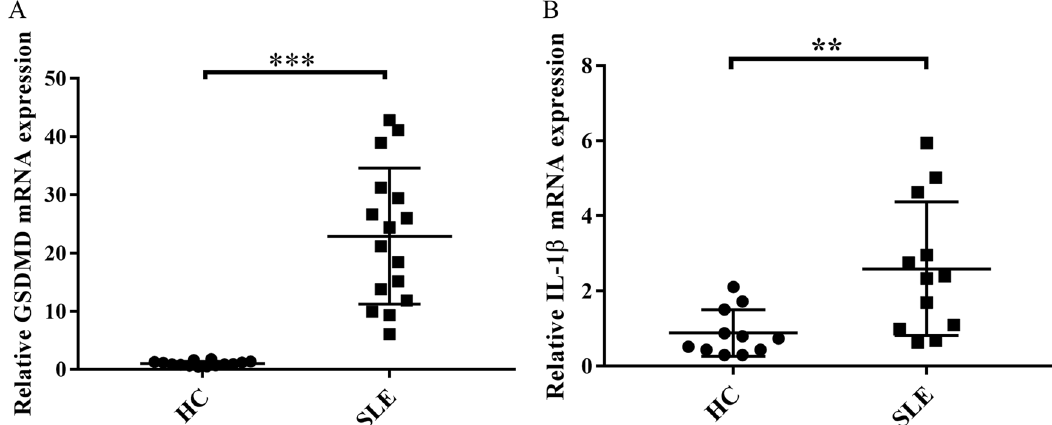
Fig. 1 mRNA expression of GSDMD and IL-1 β was increased in PBMCs from SLE patients. A GSDMD mRNA expression in PBMCs from SLE patients ( n = 16) and healthy controls (HC, n = 14). B mRNA expression of IL-1 β in PBMCs from SLE patients ( n = 12) and HC ( n = 11). mRNA determination was performed by real-time PCR. Values were shown as mean ± SD of three independent experiments. ** p < 0.01, *** p < 0.001. HC healthy controls, SLE Systemic lupus